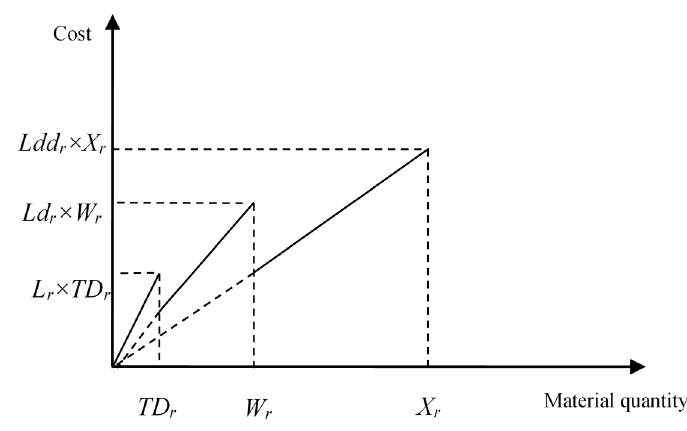
Figure 6. Direct material cost.